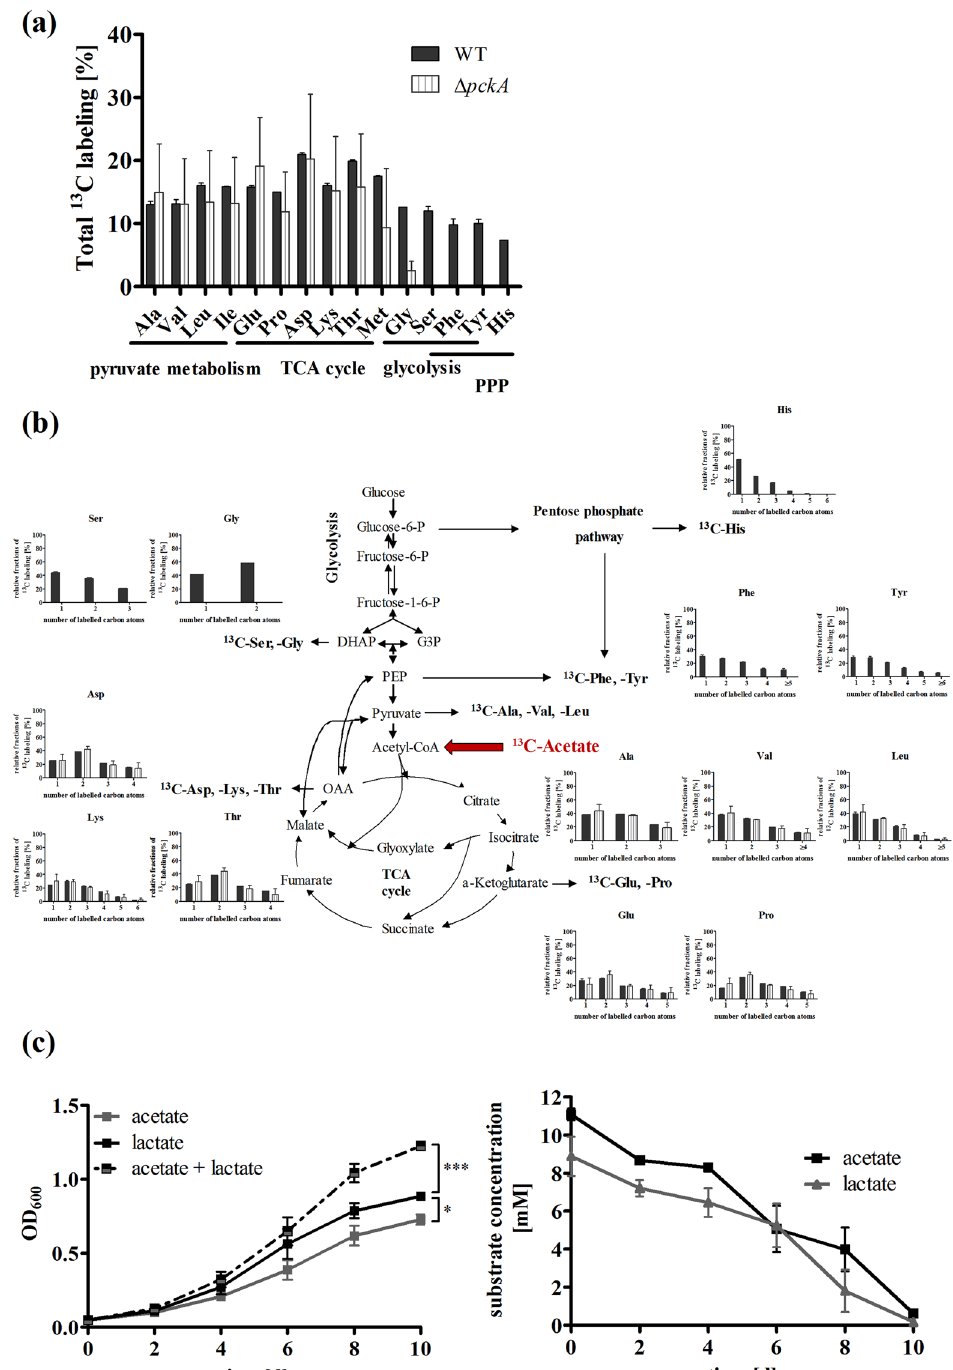
Figure 5. Comparison of acetate derived 13 C-carbon flux in Mtb wild type and the ∆ pckA mutant, and co- metabolism in Mtb wild type during growth on lactate and acetate. To characterize the acetate derived carbon flux in Mtb , the wild type strain (black bars) and the ∆ pckA mutant (striped bars) were grown for two days on medium containing 10 mM glucose and 10 mM [U- 13 C 2 ]-acetate. The overall 13 C-enrichments are depicted in ( a ). The relative fractions (%, y-axis) of 13 C-labelled isotopologues in the wild type strain (black bars) and in the ∆ pckA mutant (striped bars) with a given number of 13 C-atoms (x-axis) are shown in ( b ). Data represent the mean of two independent experiments each measured in technical triplicates; error bars indicate the SEM. ( c ) To analyse co-metabolism of lactate and acetate, Mtb H37Rv was grown in defined minimal medium containing 10 mM lactate and 10 mM acetate. Growth and substrate consumption from the medium were detected for ten days at the indicated time points. Data represent the mean of three independent experiments; error bars indicate the